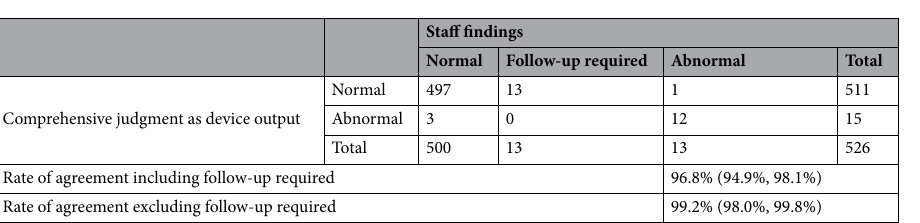
Table 1. Rate of agreement between the comprehensive risk judgment by the algorithm and the physician’s judgement. As an overall evaluation of the blood flow to the grafted tissue, the device outputs a comprehensive risk judgement calculated from the assessment of each of the three parameters as normal or abnormal. The rate of agreement between the algorithm’s judgement and the physician’s judgement was 96.8% overall when the follow-up required category was considered as abnormal. The rate of agreement was 99.2% when cases judged as neither normal nor abnormal (follow-up required) were